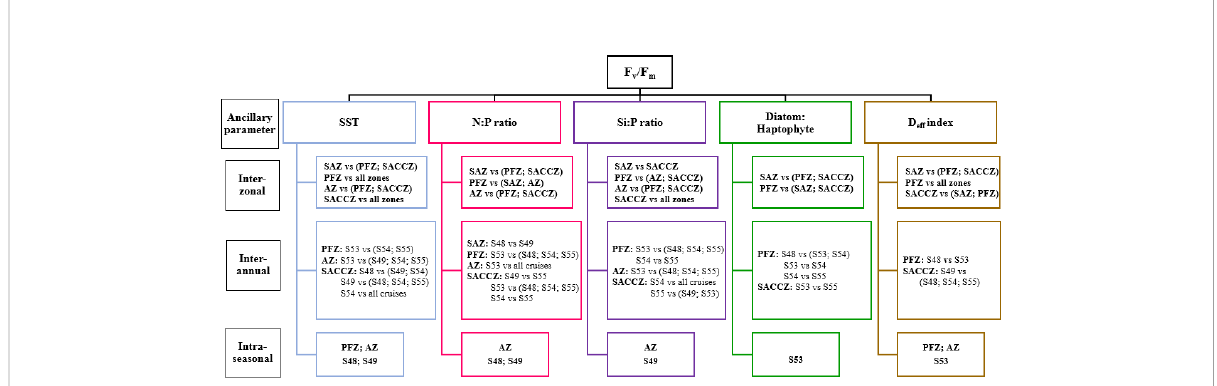
FIGURE 6 Schematic summary of the potential co-varying parameters (Surface seawater temperature, SST; Nitrate:Phosphate, N:P; Silicate:Phosphate, Si: P; Diatom:Haptophyte ratio and phytoplankton effective diameter (D eff ) index) of F v /F m (where F v /F m was different at p<0.05), showing inter- zonal, inter-annual and intra-seasonal changes that matched changes in F v /F m . The zones/cruises before “ vs ” were different to each of the zones/cruises after “ vs ” . Note all signi fi cant differences are shown where